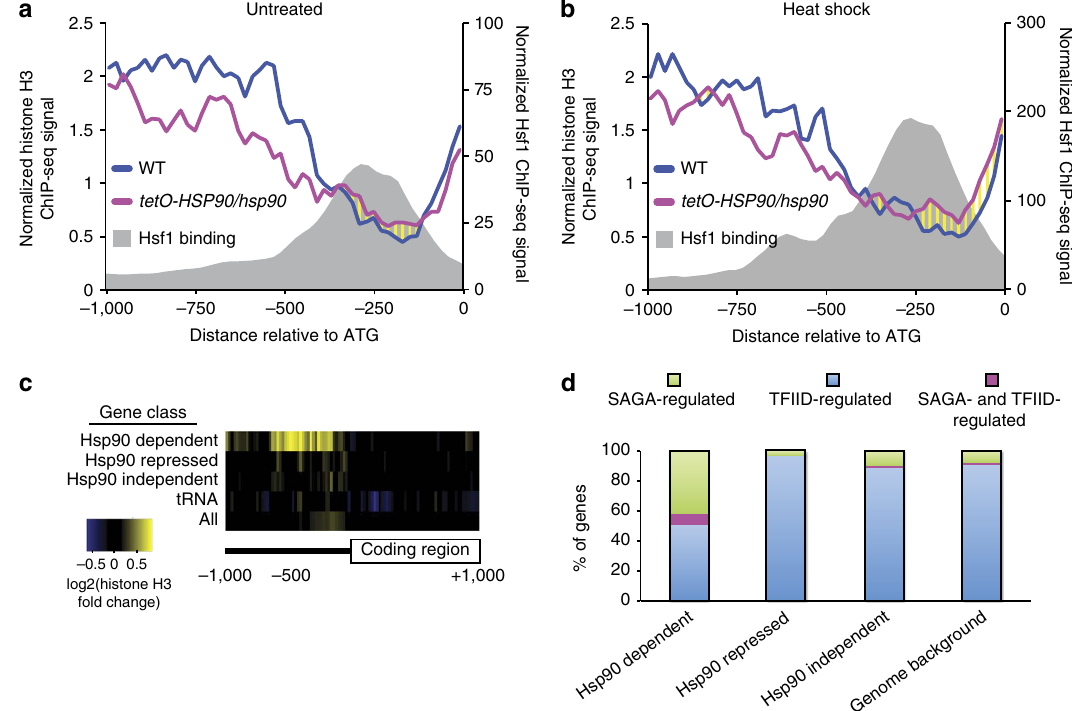
Figure 7 | Hsp90 is required for maintaining nucleosome-free regions. Schematic diagrams showing nucleosome density in wild-type (SN95, blue) and tetO-HSP90/hsp90 (red) cells, as well as Hsf1-TAP-binding position (grey shade) at Hsf1 regulated promoters with ( a ) and without ( b ) heat shock. ( c ) Heat map illustrating nucleosome density changes upon HSP90 depletion 1kb upstream and downstream of indicated classes of genes. Yellow represents an increase and blue represents a decrease in nucleosome density. ( d ) Histogram representing the per cent of Hsp90-dependent or—repressed genes regulated by SAGA or TFIID compared with Hsp90-independent genes and the genome during heat shock impairs histone gene expression. Fourth, factor II D), we discovered that Hsp90-repressed genes are almost by identifying orthologs of S. cerevisiae genes controlled by exclusively controlled by TFIID, whereas Hsp90-dependent genes SAGA (Spt-Ada-Gcn5-acetyltransferase) or TFIID (transcription are dominated by SAGA (Fig. 7d); this is in keeping with the